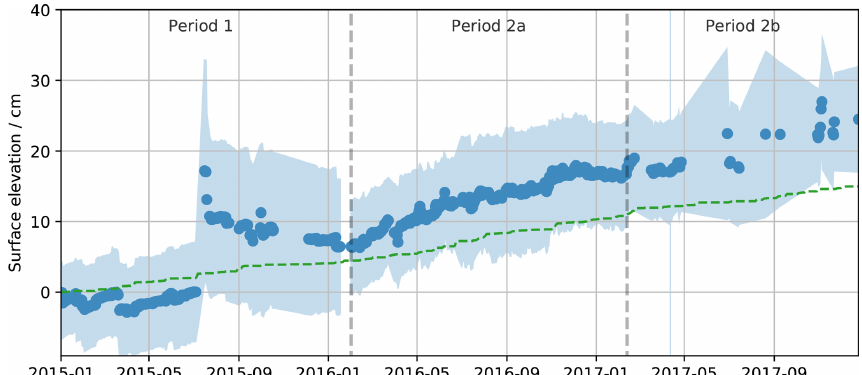
Figure 3. Evolution of the mean surface elevation and rms height in the scanned area observed by RLS (blue) and of the cumulative precipitation forecast from ERA-Interim at Dome C (green) converted in snow depth assuming a surface density of 320kgm − 3 . The blue shade shows ± 1 rms height around the mean.